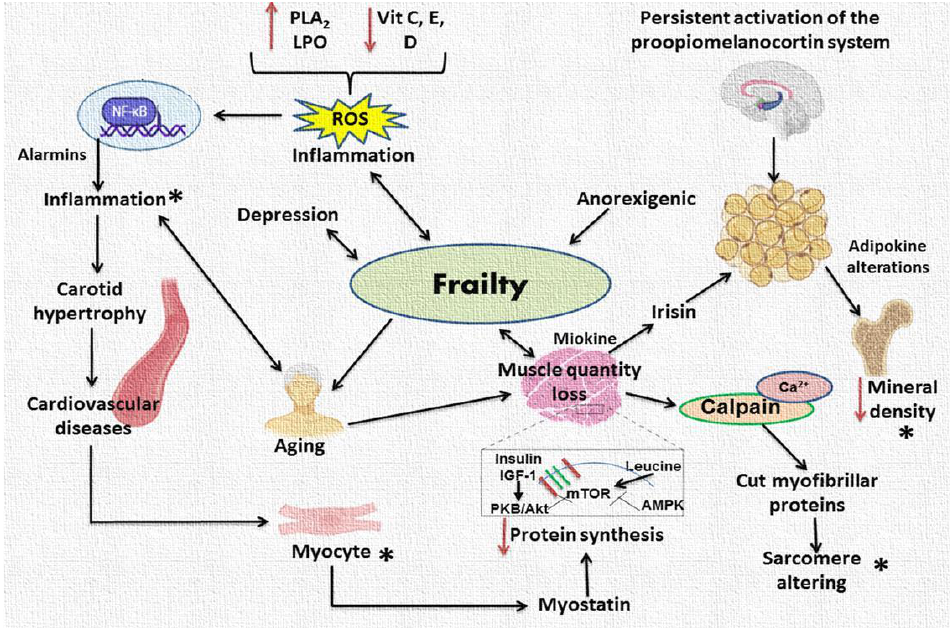
Figure 3. Summary of the different topics reviewed in this article. Development of frailty; inflam- mation as the main pathophysiological feature and systemic alterations related to it. Abbreviations: Ca 2+ = Calcium, IGF-1 = Insulin-like growth factor 1, TOR = Mammalian target of rapamycin, LPO = Lipoperoxidation, NF- κB = Nuclear factor kappa b, PLA 2 = Phospholipase A 2 , ROS = Reactive oxygen species, * = Interconnected routes in frailty.